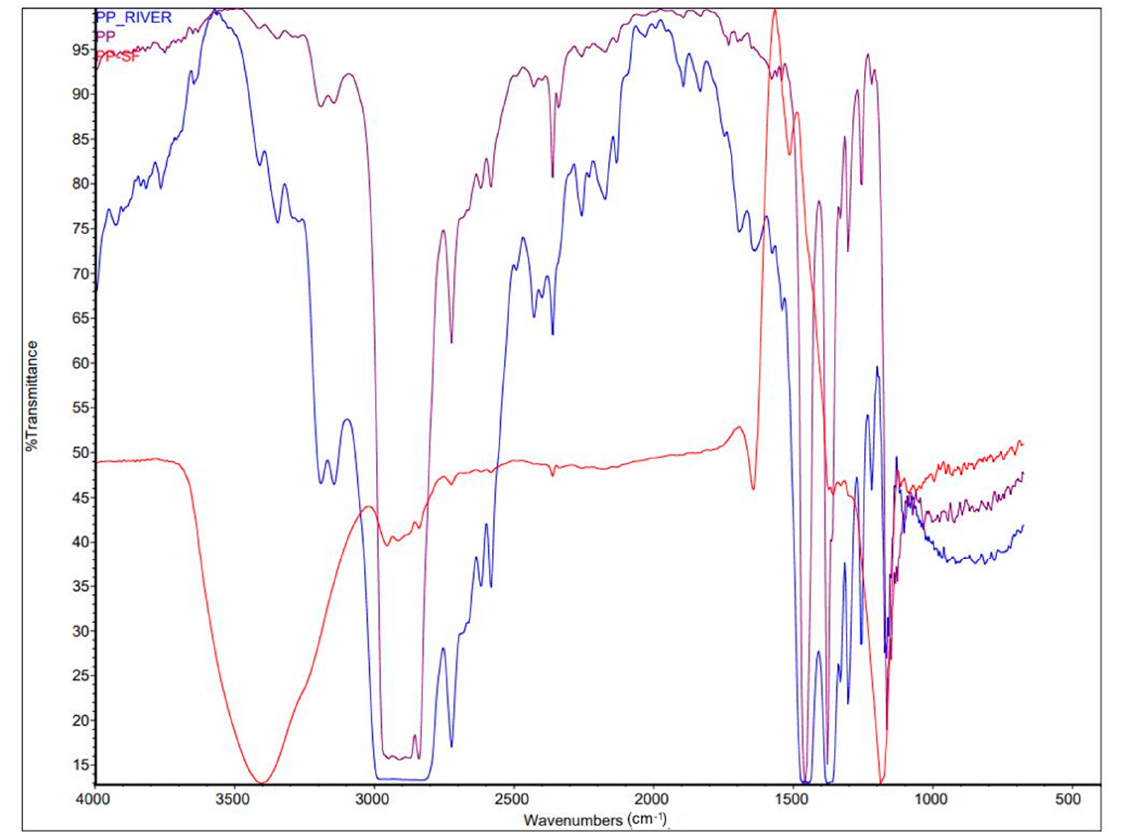
Figure 3. µFT-IR mean spectra ( n = 10) acquired in transmission mode of unconditioned microplastics (PP, violet) vs. microplastics conditioned in riverine water (PP-river, blue) vs. microplastics conditioned in surfactant solution (PP-sf, red).